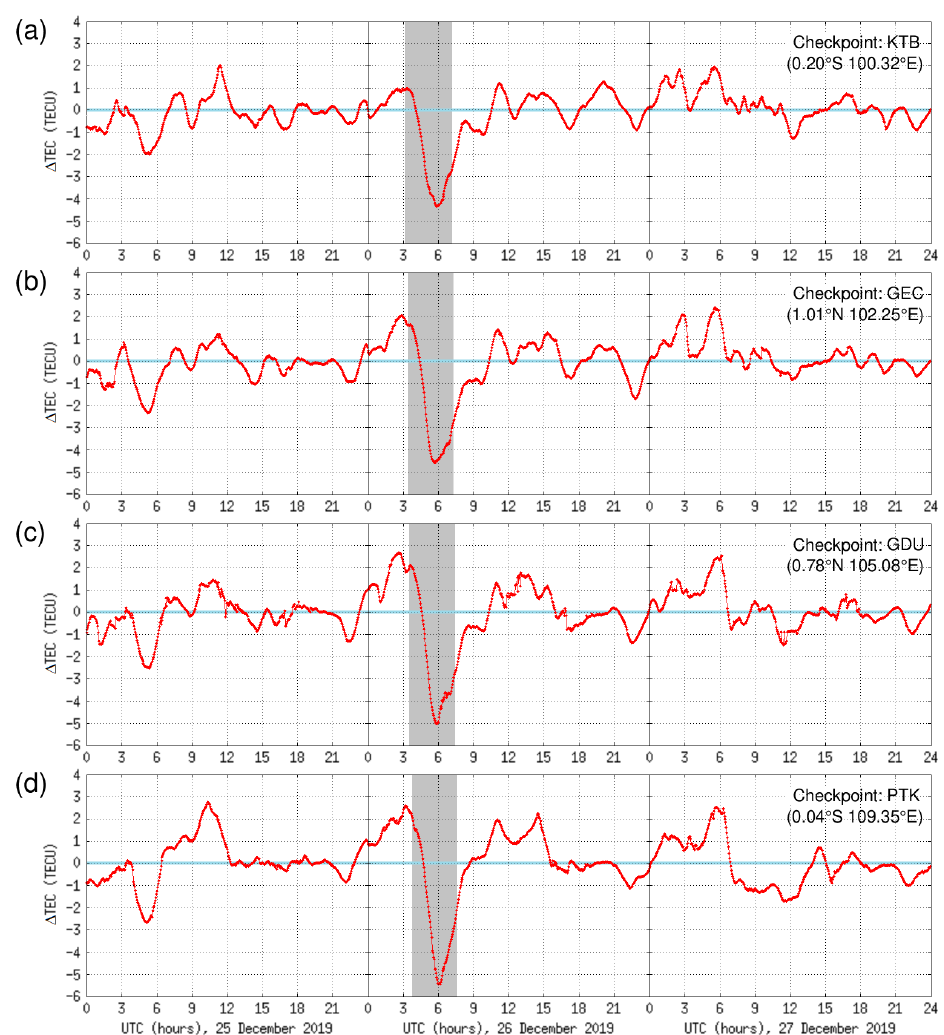
Figure 10. (a–d) Time series plots of (cid:49) TEC at the four designated checkpoints (KTB, GEC, GDU, and PTK) on 25–27 December 2019, obtained by subtracting the smooth background TEC level from the GPS TEC observation data. The solar eclipse period is indicated with gray